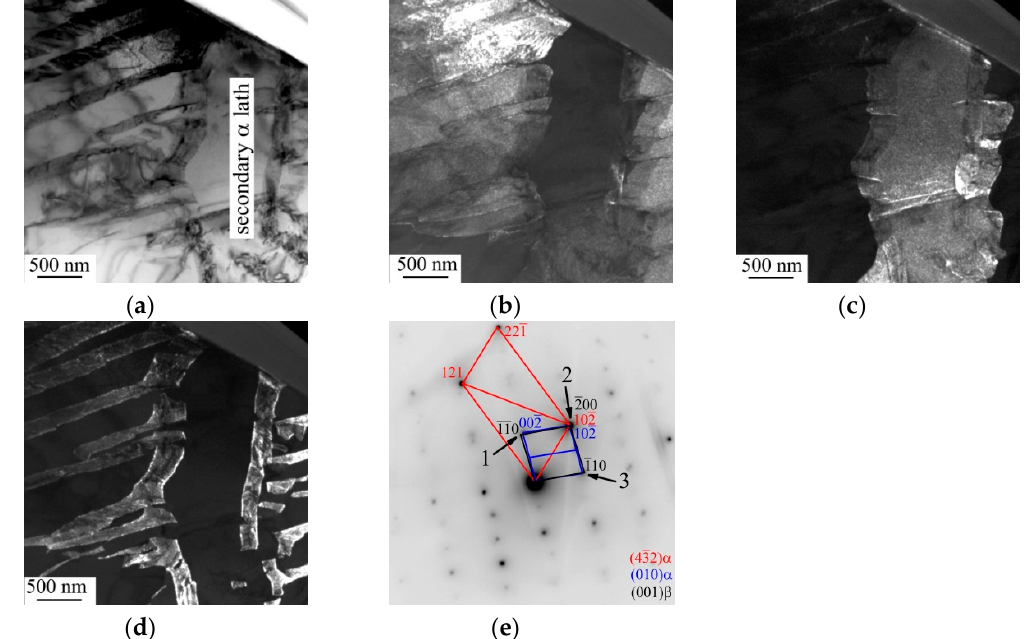
Figure 6. TEM bright- ( a ) and dark-field images ( b – d ) and associated selected area electron di ff raction (SAED) pattern ( e ) of the microstructures within the outermost surface layer of the EBF 3 -fabricated Ti–6Al–4V sample. b—the dark-field TEM image obtained with the 002 α -Ti and 110 β -Ti reflections (marked by an arrow 1 in ( e )), c—dark-field TEM image obtained with the 102 α -Ti and 200 β -Ti reflections (marked by an arrow 2 in ( e )), d—dark-field TEM image obtained with the 110 β -Ti and 002 α ”-Ti reflections (marked by an arrow 3 in ( e )).